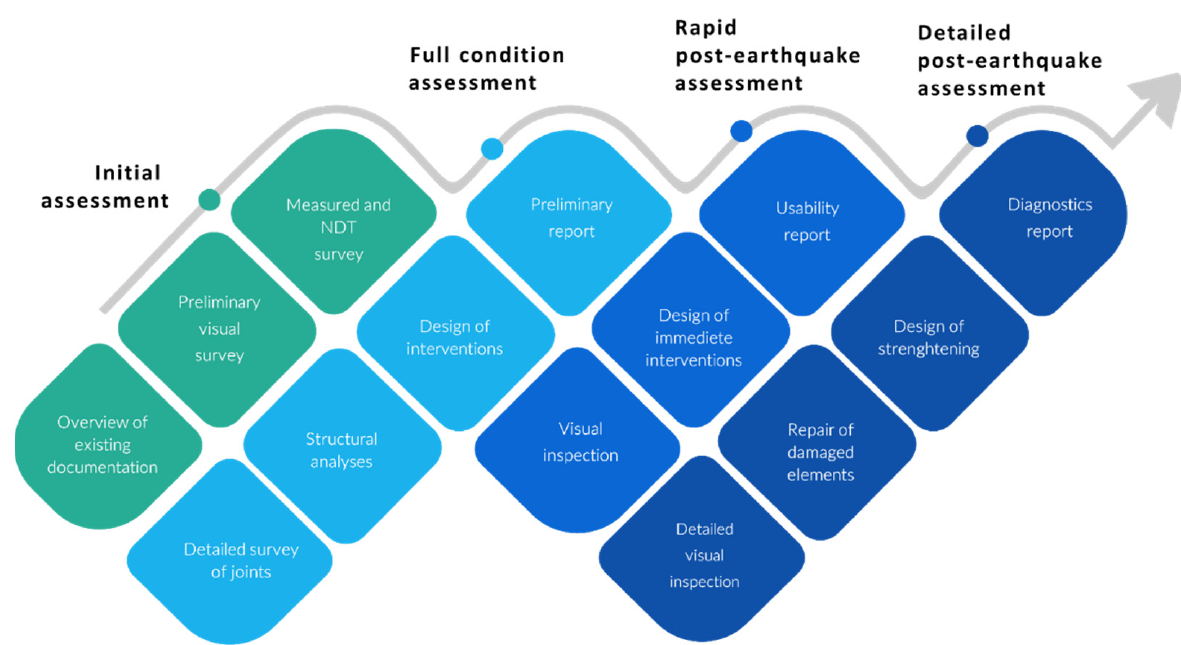
Figure 12. Actions needed for different assessment